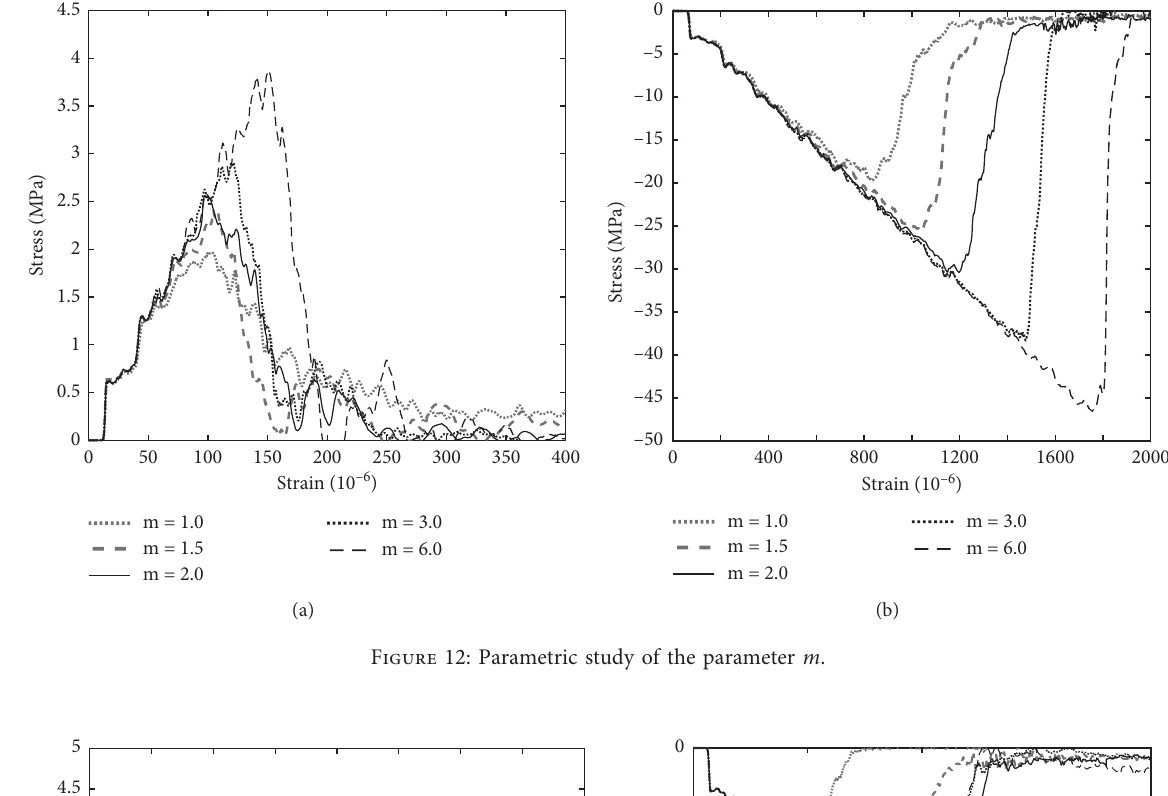
Figure 12: Parametric study of the parameter m .